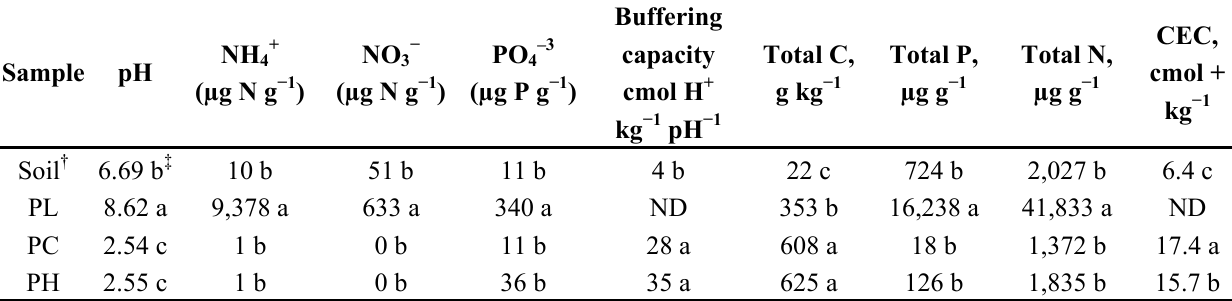
Legend for Table 1: PL refers to poultry litter; PC and PH refer to biochar from pine chips and peanut hulls, respectively. ND means not determined. ‡ Within each column, different letters (a,b,c) mean significant difference between treatments at 0.05 level of significance. † means soil + sand